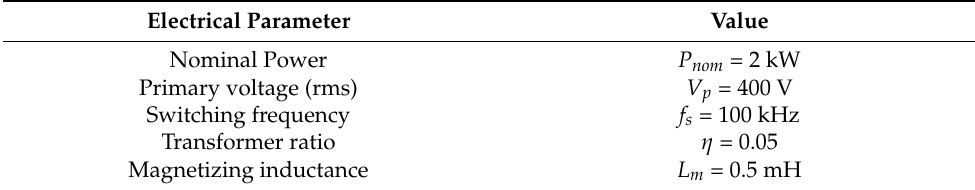
Table 1. Planar transformer electrical